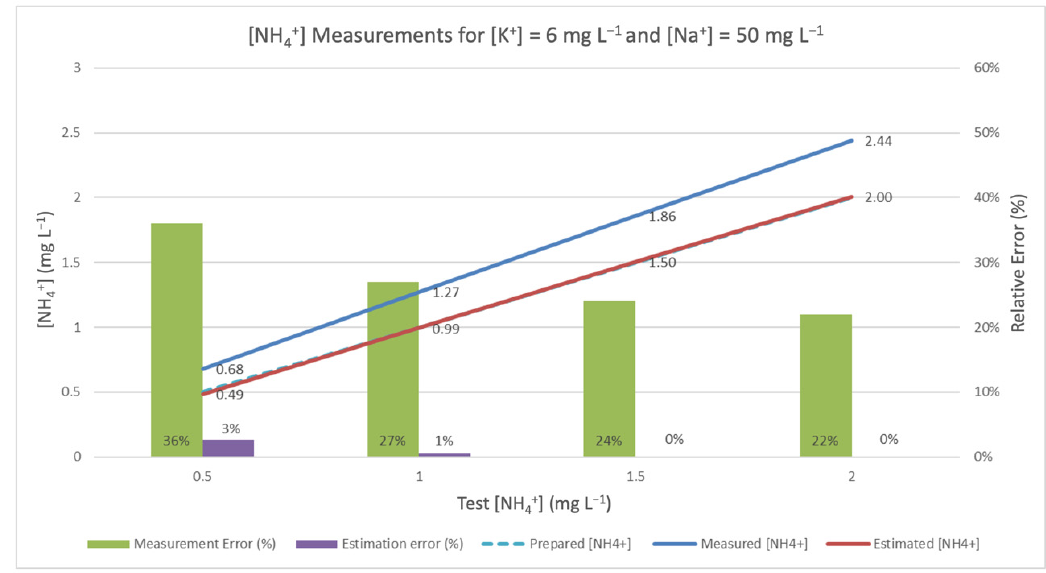
Figure 3. Measured and corrected [NH 4 + ] in the presence of [K + ] = 6.0 mg L − 1 and [Na + ] = 50 mg L − 1